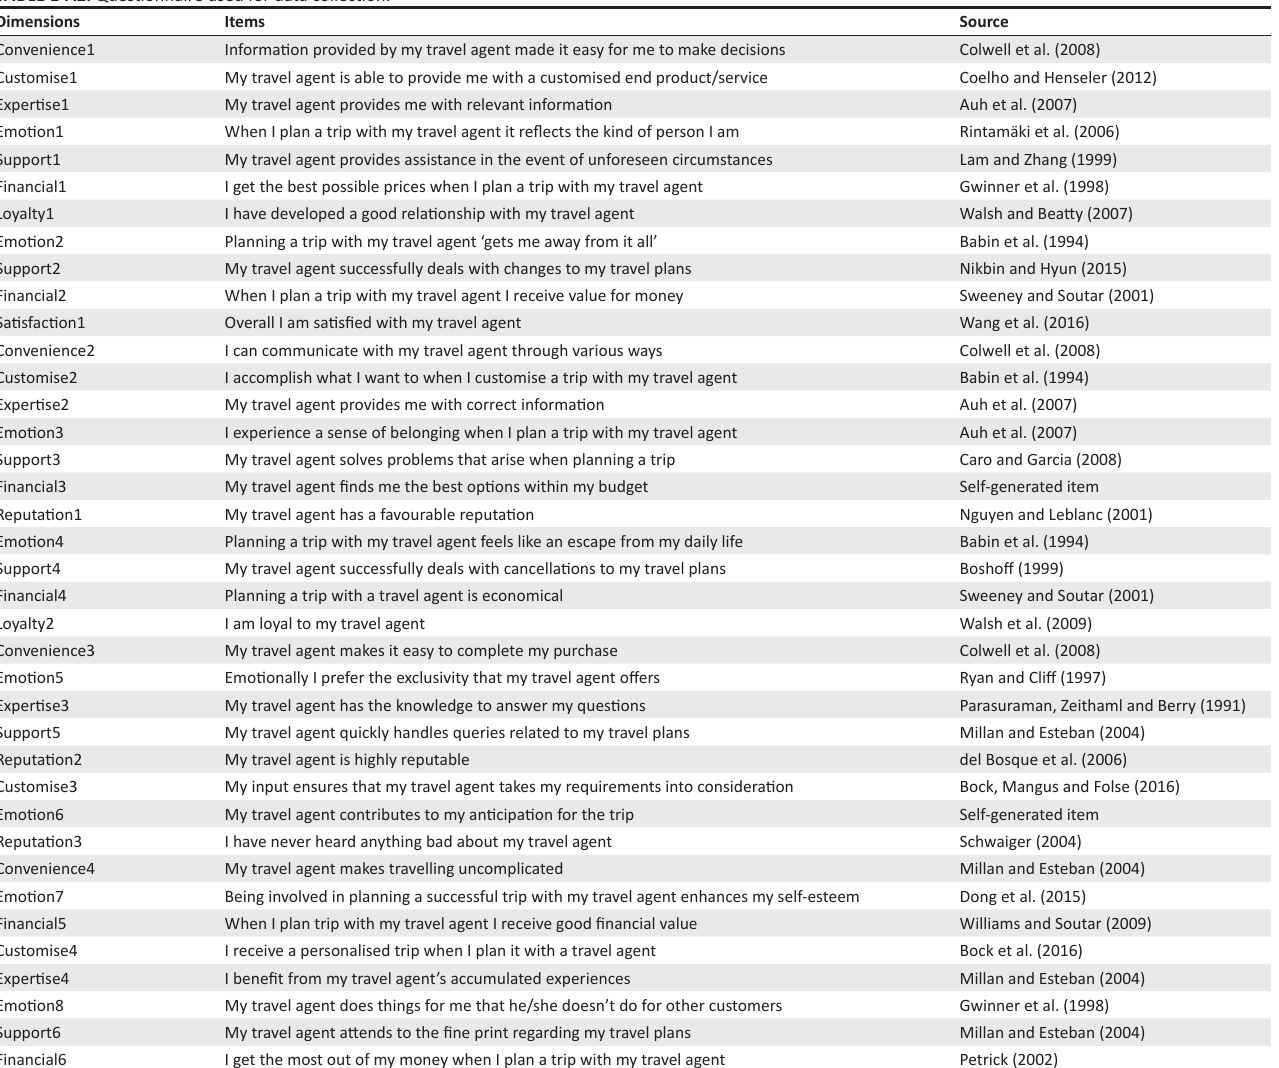
TABLE 1-A2: Questionnaire used for data collection.